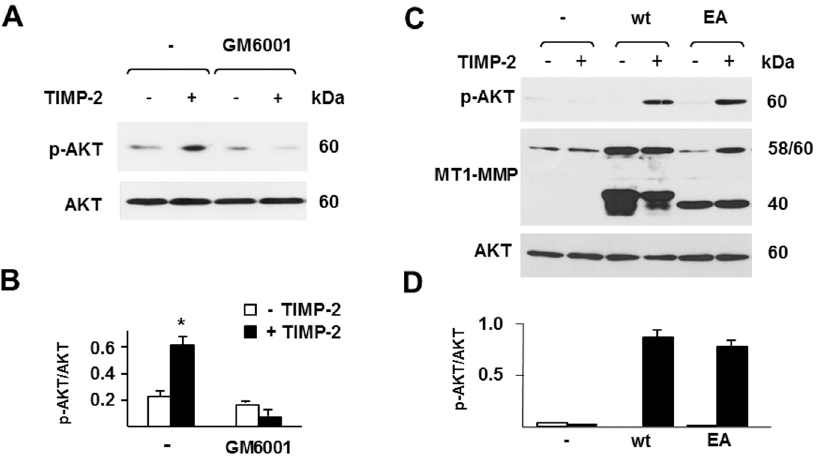
Fig 4. TIMP-2 induction of AKT activation does not require the proteolytic activity of MT1-MMP. A and C . Western blotting analysis of AKT activation (pAKT) in ( A ) MT1-MMP-expressing Tet-Off MCF-7 cells pretreated with Ilomastat (GM6001; 50 μ M) or control vehicle (-) for 15 min, and ( C ) MCF-7 cells transiently transfected with the cDNAs for either wt MT1-MMP (wt) or MT1-MMP E240A (EA), and treated with TIMP-2 (100 ng/ml) or control medium (-) for 15 min. Cell protein extracts of the transient transfectants (C) were also analyzed for MT1-MMP expression. In the MT1-MMP panel the 60 kDa and the 58 kDa bands represent the proenzyme and the active proteinase forms, respectively; the 40 kDa M r bands represent degradation products generated by autocatalysis or by other proteinases. Total AKT is shown as a loading control. B and D . Densitometric analysis. * , p (cid:1) 0.05; + TIMP-2 vs . the corresponding – TIMP-2 sample. These experiments were repeated twice with comparable